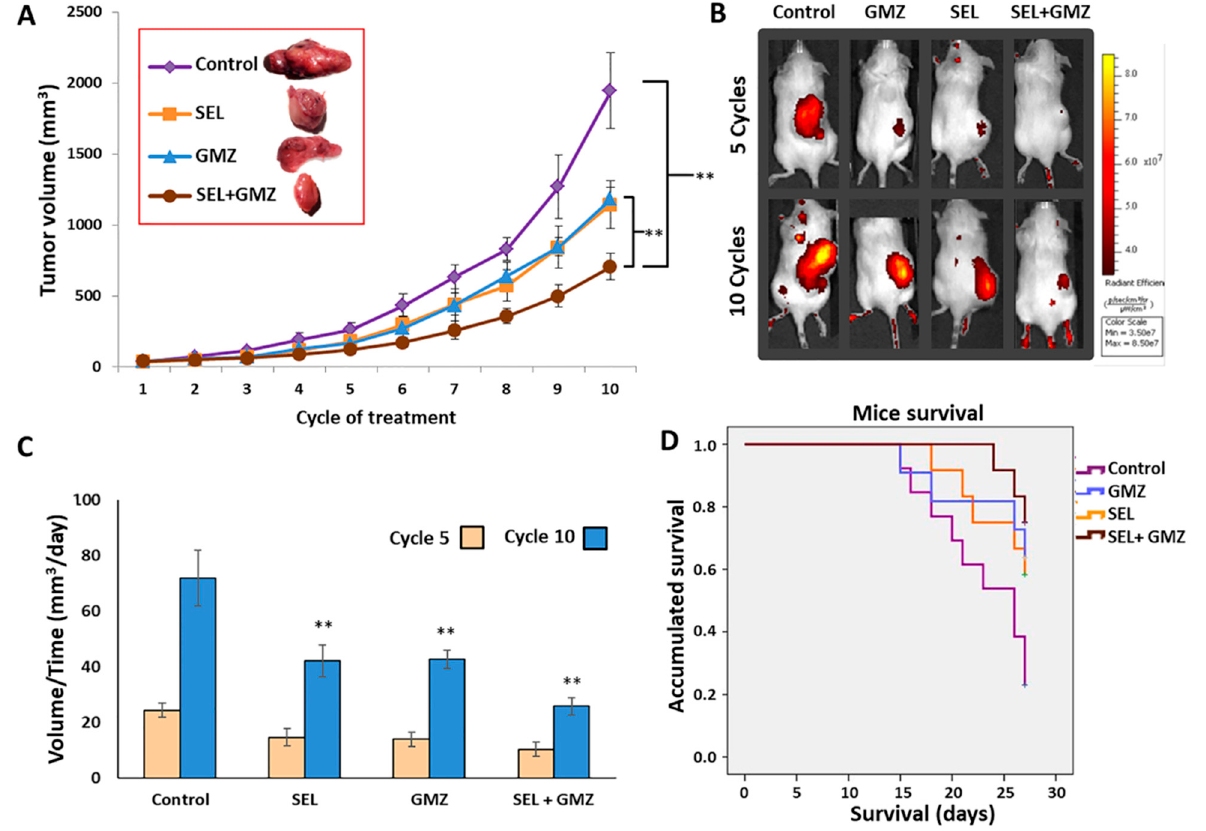
Figure 6. In vivo tumor growth inhibition and mice survival after treatment with sodium selenite. ( A ) Graphic representation of pancreatic tumor (Pan02 cancer cells) volume growth in C57BL/6 mice. Mice were treated with sodium selenite, GMZ and sodium selenite + GMZ. Untreated mice were used as controls. Data are presented as mean ± SD ( n = 13). ** Significant inhibition of tumor growth comparing treatments and comparing treatments with control ( p < 0.01). ( B ) IVI Spectrum analysis of mice after different treatment protocols (5 and 10 cycles). Images were obtained after 3 h of (DG)-750 injection. ( C ) Tumor growth inhibition in volume/time (mm 3 /day) (** p < 0.01, comparing treatments and comparing treatments with control). ( D ) Kaplan–Meier curves of mice bearing subcutaneous tumors. Data were analyzed according to mice survival in each group. Comparison between treatment groups was performed using the log-rank test. GMZ (gemcitabine); SEL (sodium selenite).